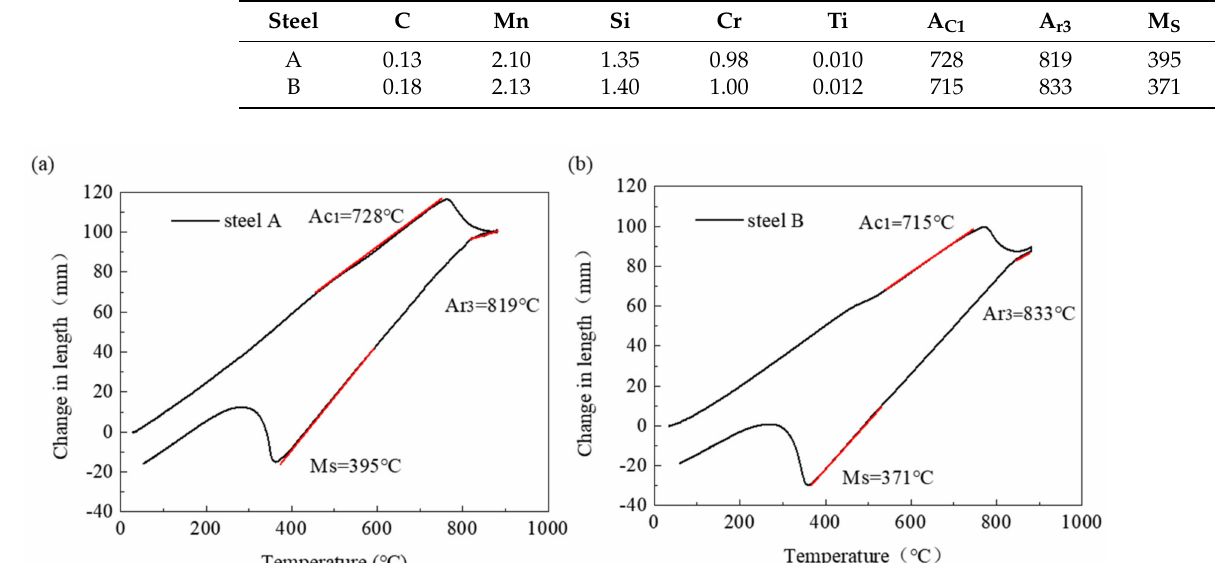
Figure 1. Dilatometric curves and phase transformation temperature of the experimental steels: ( a ) steel A and ( b ) steel